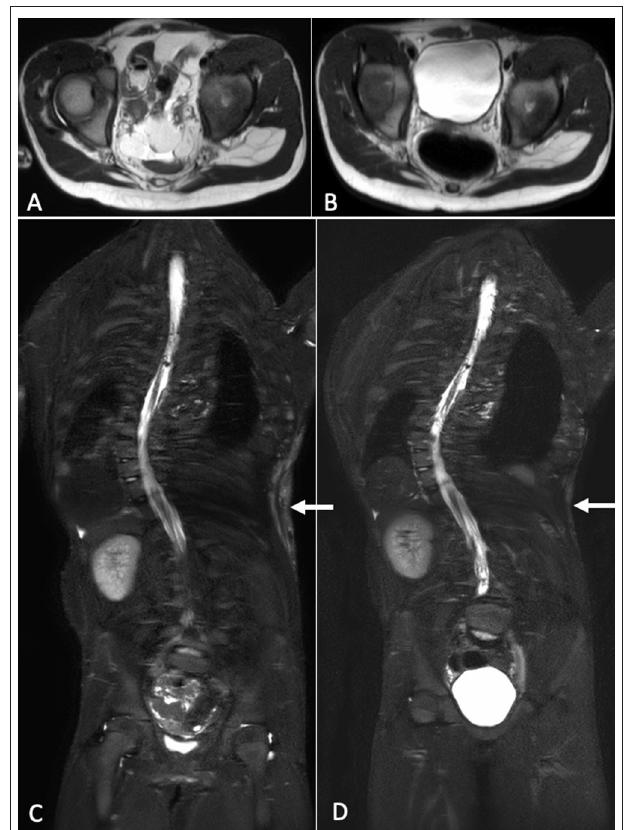
FIGURE 2 | Axial T2-weighted MR images at baseline (A) and after about 6 months of therapy (B) . A reduction of the soft tissues and visceral lipomatous overgrowth can be observed after treatment. Coronal STIR-weighted MR images show high-signal-intensity alteration in the soft tissues of the left flank consisting with low-flow vascular malformation, at baseline (C) and after therapy (D) . After therapy, it was evident a reduction of the vascular